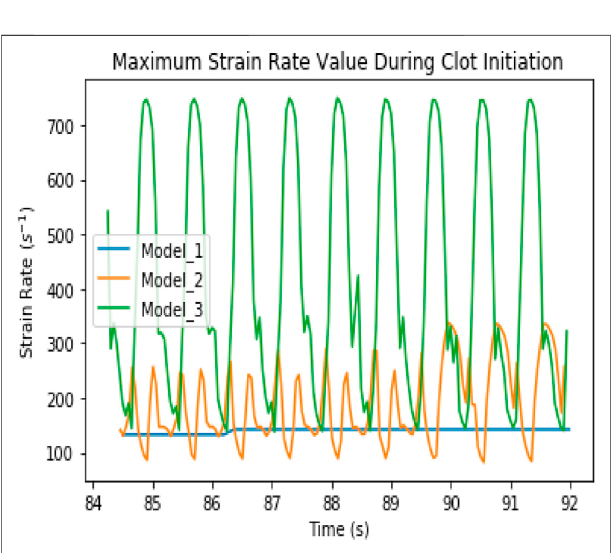
Frontiers in Physics |